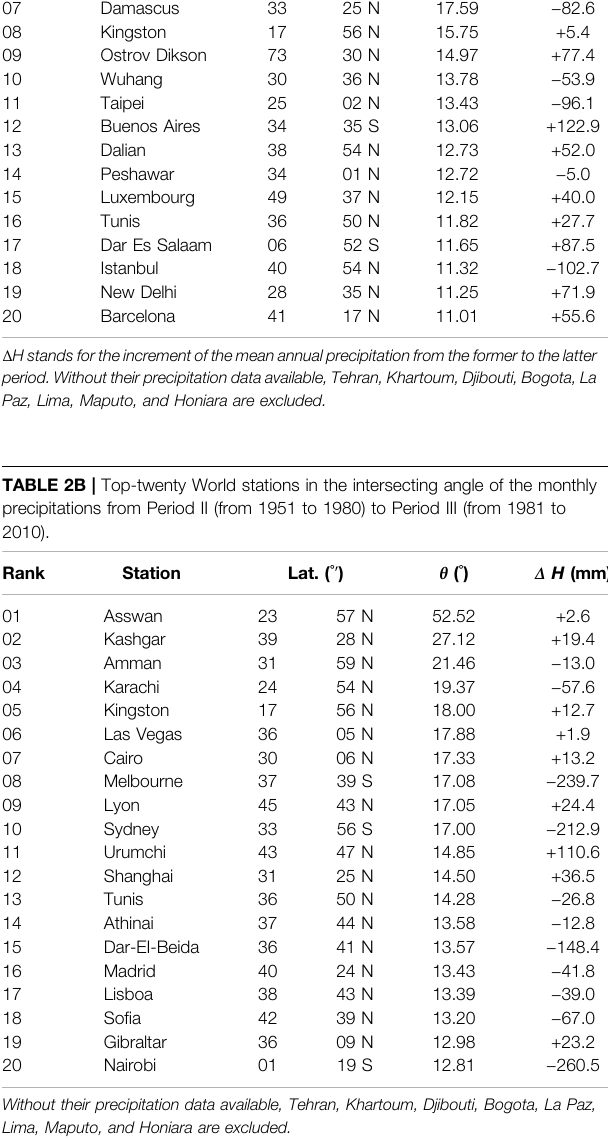
TABLE 2A | Top-twenty World stations in the intersecting angle of the monthly precipitations from Period I (from 1931 to 1960) to Period II (from 1951 to 1980).